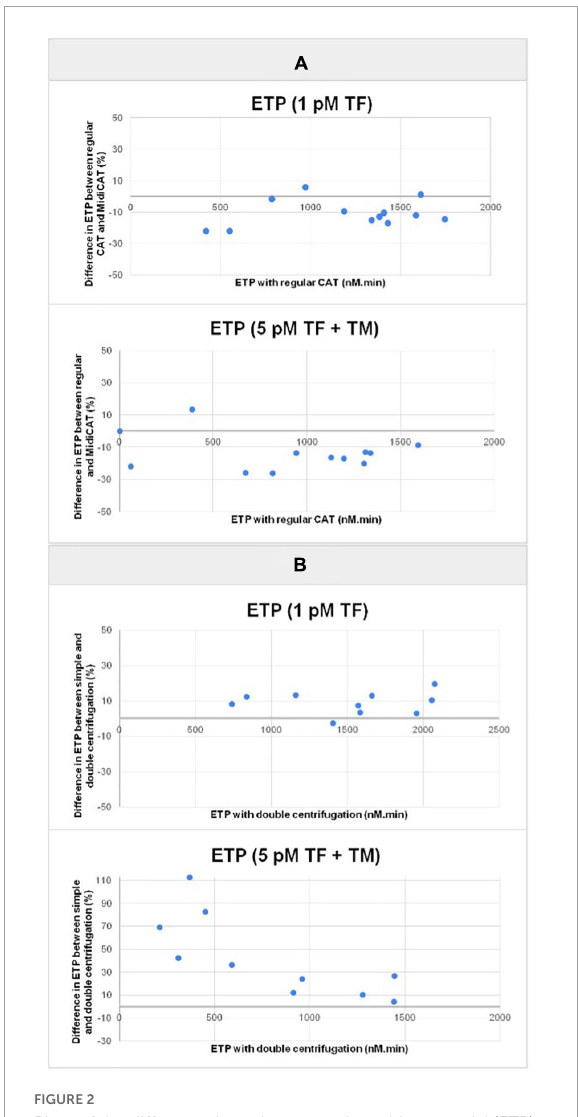
FIGURE2 Plots of the difference in endogenous thrombin potential (ETP) between the variant methods and the reference method in percentage vs. endogenous thrombin potential (ETP) obtained with the reference method. TG was initiated with 1 pM TF alone, and with 5 pM TF combined with TM with 10 plasma samples (patients). Panel (A) comparison of MidiCAT variant method